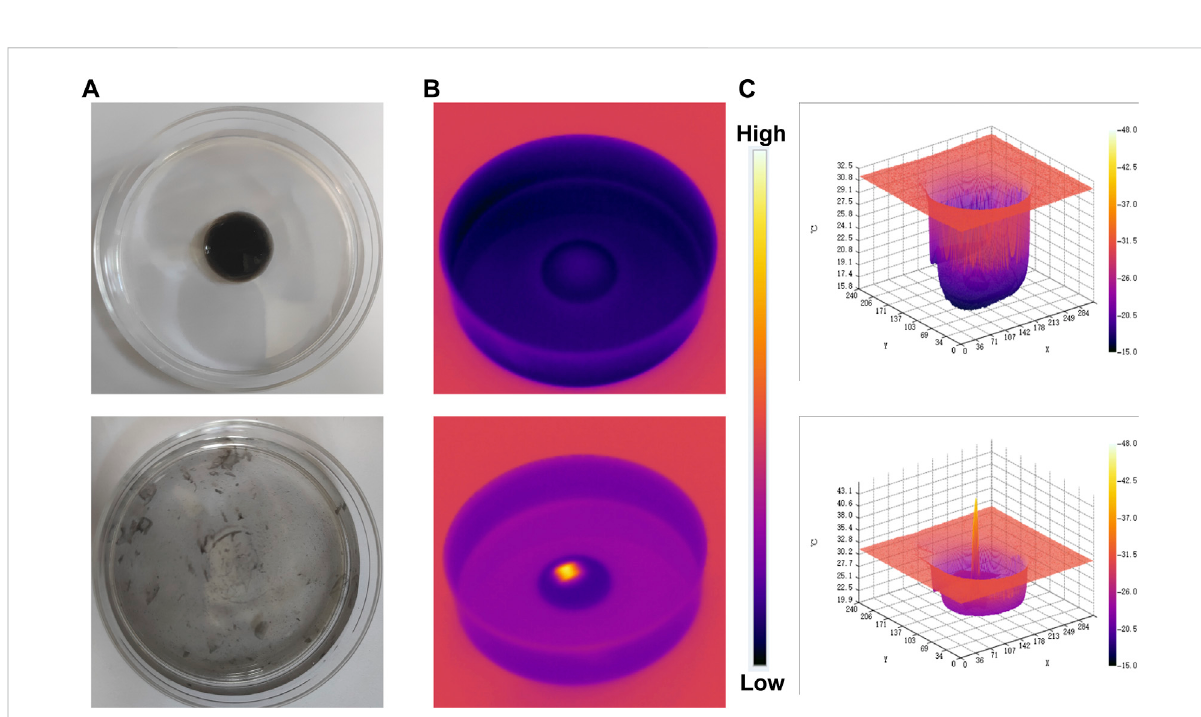
FIGURE 3 (A) Themorphology ofthepreparedFMHbeforeand after 0.5 W/cm2 808 nm laser irradiation for 5 min. (B) The infrared thermalimagesofthe prepared FMH before and following irradiation. (C) Relevant 3D temperature diagram in